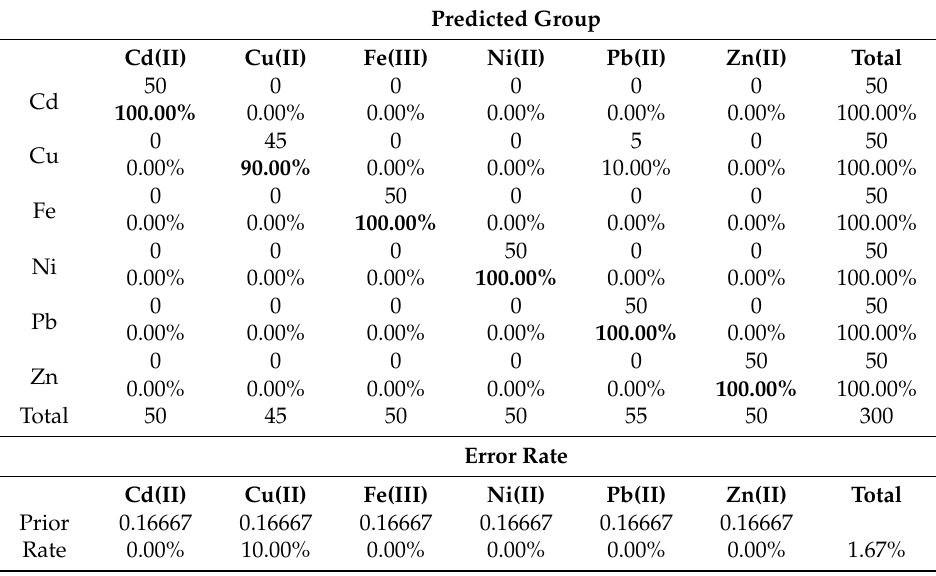
Table 5. Classification counts and error rates of different metallic ions obtained after processing and analyzing the output signal from the multispectral sensor by the linear discriminant analysis